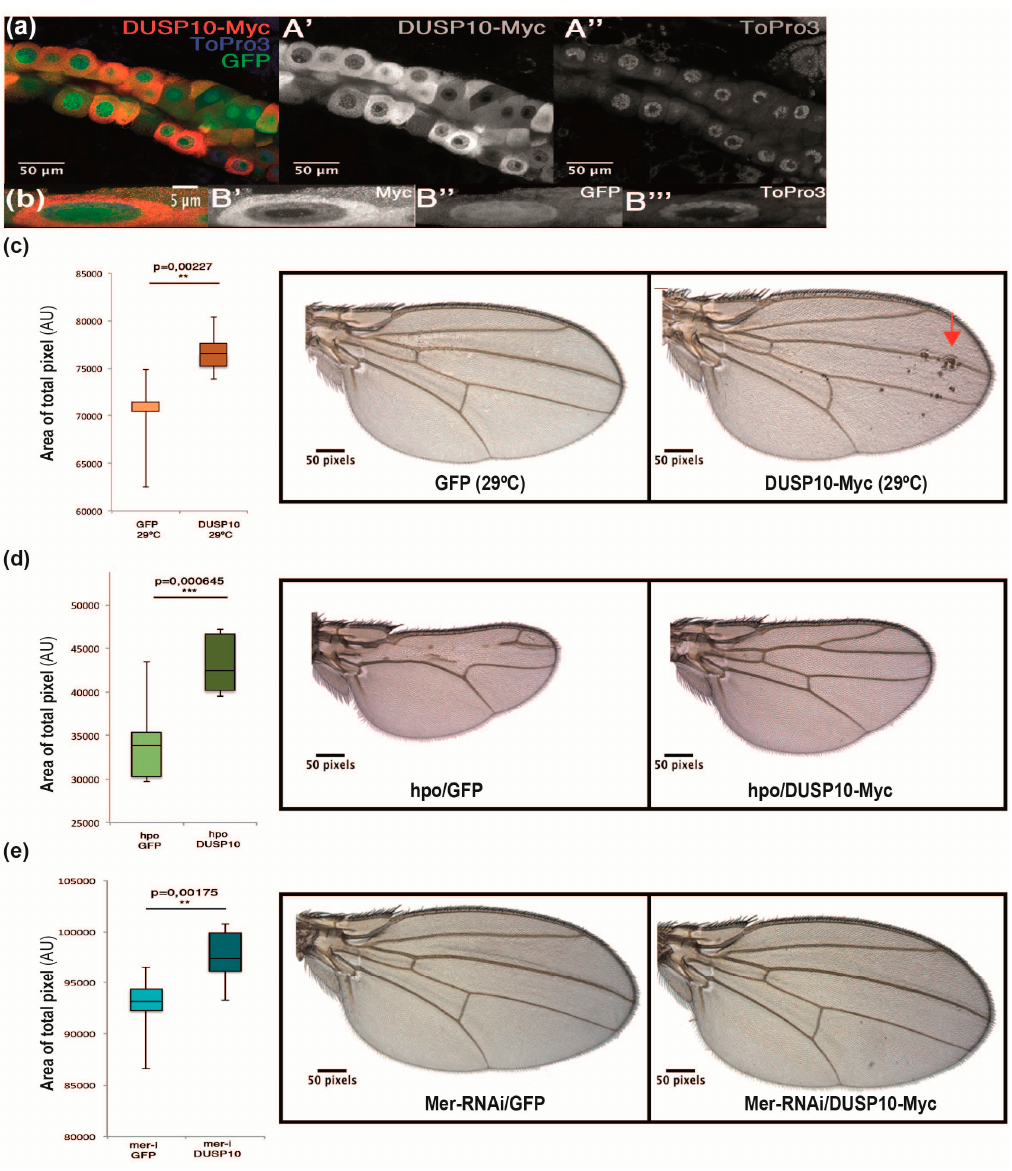
Figure 5. Effect of DUSP10 expression on Hippo-Salvador-Warts pathway in Drosophila melanogaster . ( a ) Subcellular localization of DUSP10-Myc (red) in salivary gland cells in sal EPv -Gal4 UAS-GFP/+; UAS-DUSP10-Myc/+ flies. ToPro3 (blue) was used as DNA marker and nuclei were detected by GFP (green) expression. Bars, 50 µm. ( b ) Higher magnification of a salivary gland cell from sal EPv -Gal4 UAS-GFP/+;UAS-DUSP10-Myc/+ individuals. Transversal section was represented. Bars, 5 µm. ( c ) Quantification of wing surfaces from anterior margin to L5 vein in wild type sal EPv -Gal4 UAS-GFP/+ (GFP) and sal EPv -Gal4/+;UAS-DUSP10-Myc/+ (DUSP10-Myc) individuals. Representative images of wing surfaces of both genotypes. Some cell clusters were detected between the two epithelial wings’ surfaces (red arrow). ( d ) Quantification of wing surfaces from margin to L5 vein in Ste- 20 protein kinase hippo overexpressing alone ( sal EPv -Gal4 UAS-GFP/UAS-hpo, hpo/GFP) and combined to human DUSP10-Myc ( sal EPv -Gal4/UAS-hpo;UAS-DUSP10-Myc/+, hpo/DUSP10-Myc) individuals. Representative images of wing surfaces for both genotypes. ( e ) Quantification of wing surfaces from margin to L5 vein in Merlin/Nf2 knockdown alone ( sal EPv -Gal4 UAS-GFP/+;UAS-Mer-RNAi, Mer-RNAi/GFP) and combined to human DUSP10-Myc ( sal EPv -Gal4/UAS-Mer-RNAi;UAS-DUSP10-Myc/+, Mer-RNAi;DUSP10-Myc) individuals. Representative images of wing surfaces for both genotypes. All graphs were represented by the media ± standard deviation (SD) ( n = 10). Student’s t -test was performed to compare genotypes ( ** p < 0.01; *** p < 0.001).